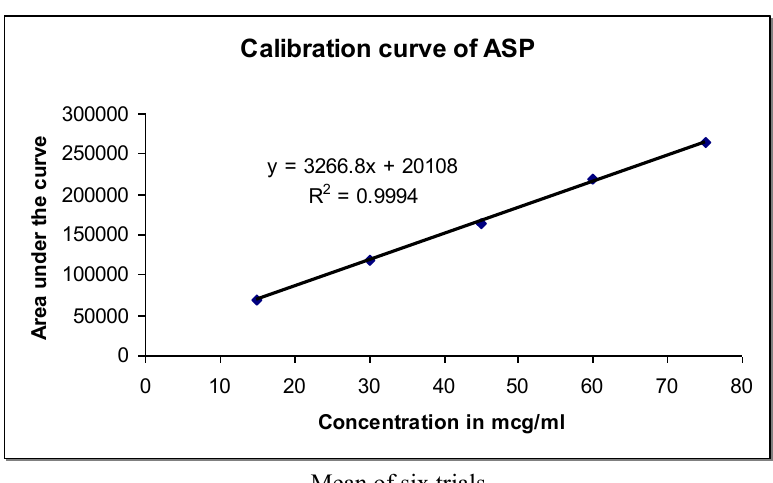
Figure 3. Linearity graph of Aspirin